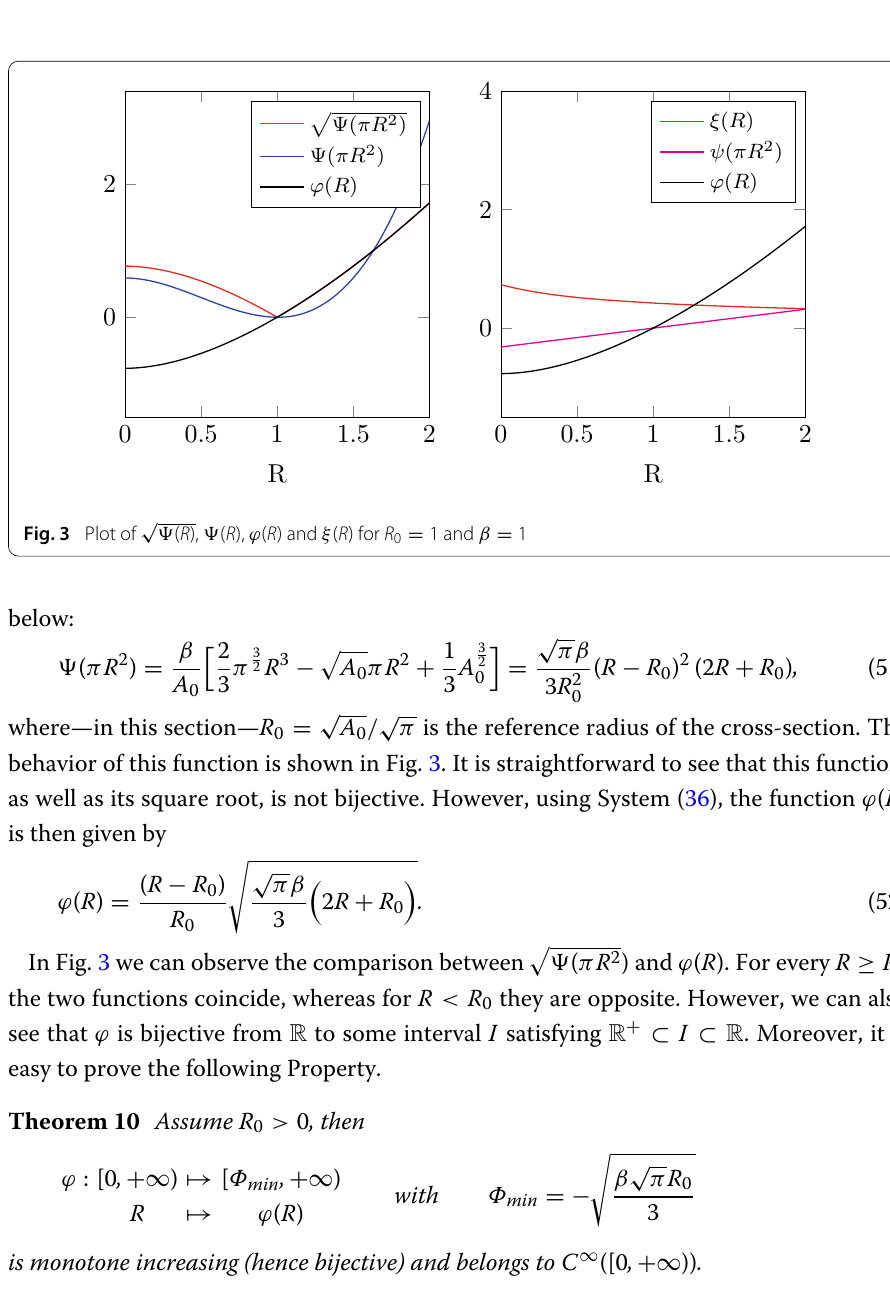
√ (cid:10) ( R ), (cid:10) ( R ), ϕ ( R ) and ξ ( R ) for R